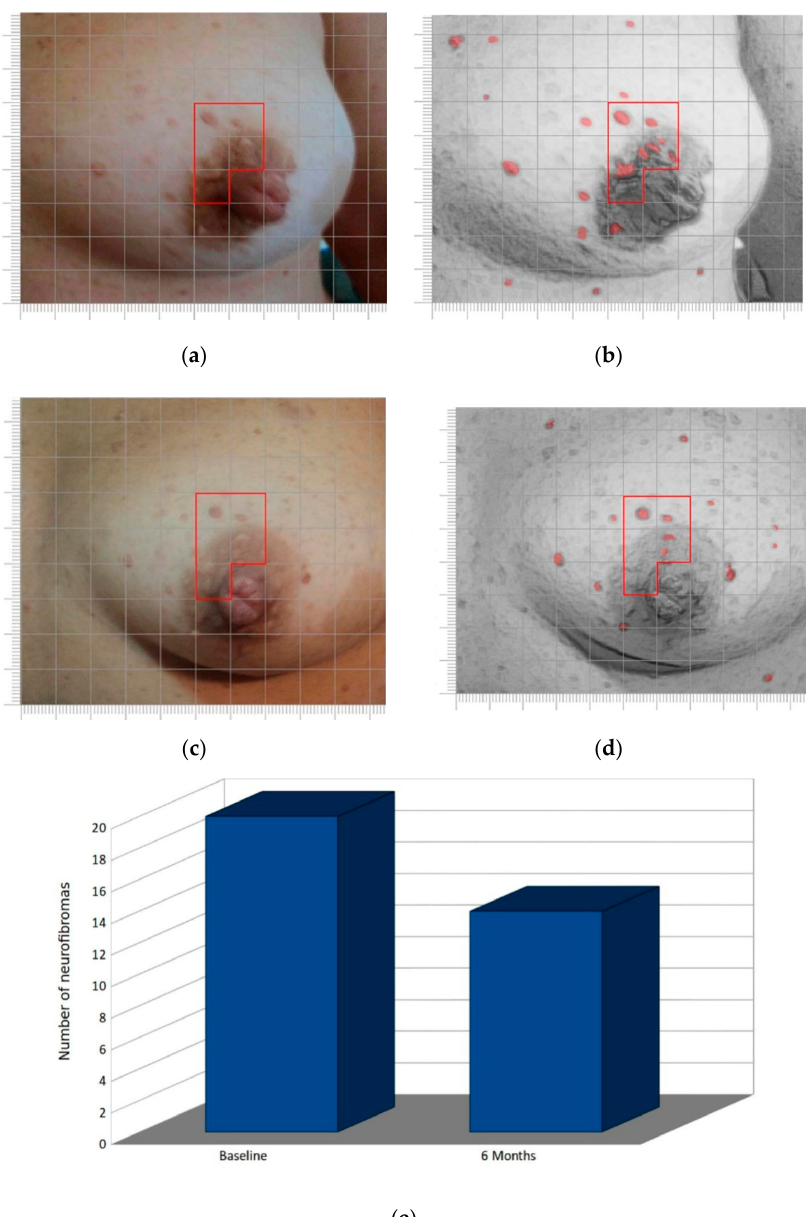
Figure 3. Left breast of case 10: serial clinical assessment. ( a , c ). Clinical observation at baseline ( a ) and after six months of MedDietCurcumin ( c ); the red border is provided for reference; ( b , d ) Digital reworking of the image in A and C to facilitate manual counting of cutaneous neurofibromas; ( e ) Bar chart representing the number of neurofibromas in the sampled area at baseline and at six-month follow-up.